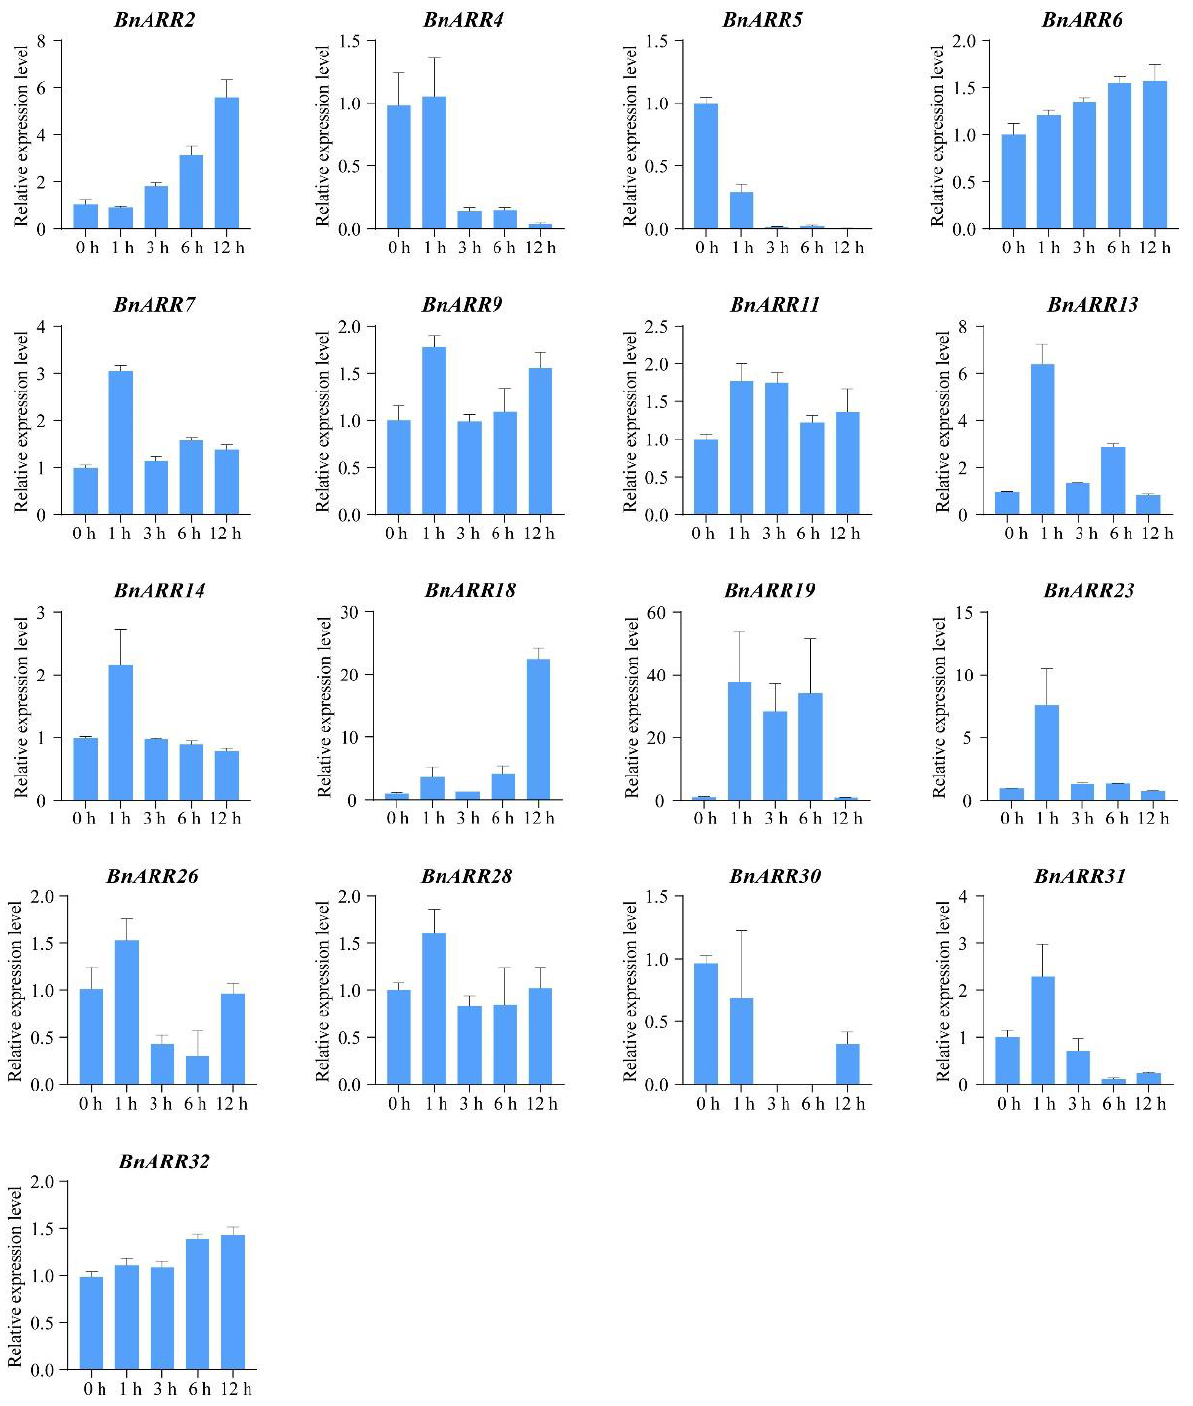
Figure 10. Type-B BnARRs expression in response to CTK treatment. The data was represented as mean ± standard deviation ( n = 3).